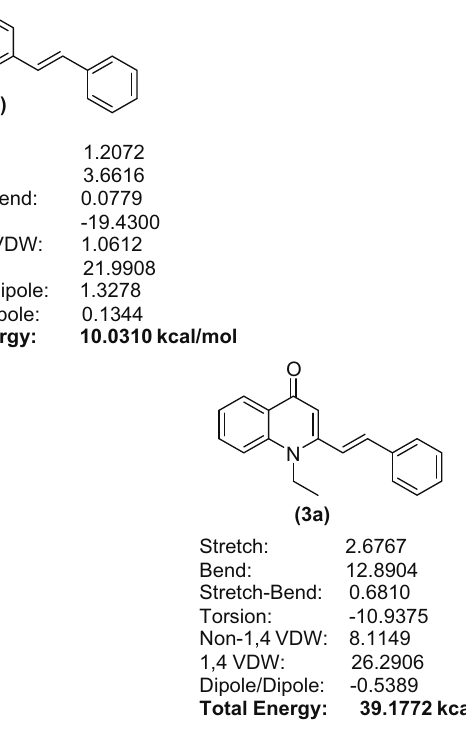
Figure 4: Energy of intermediate and the